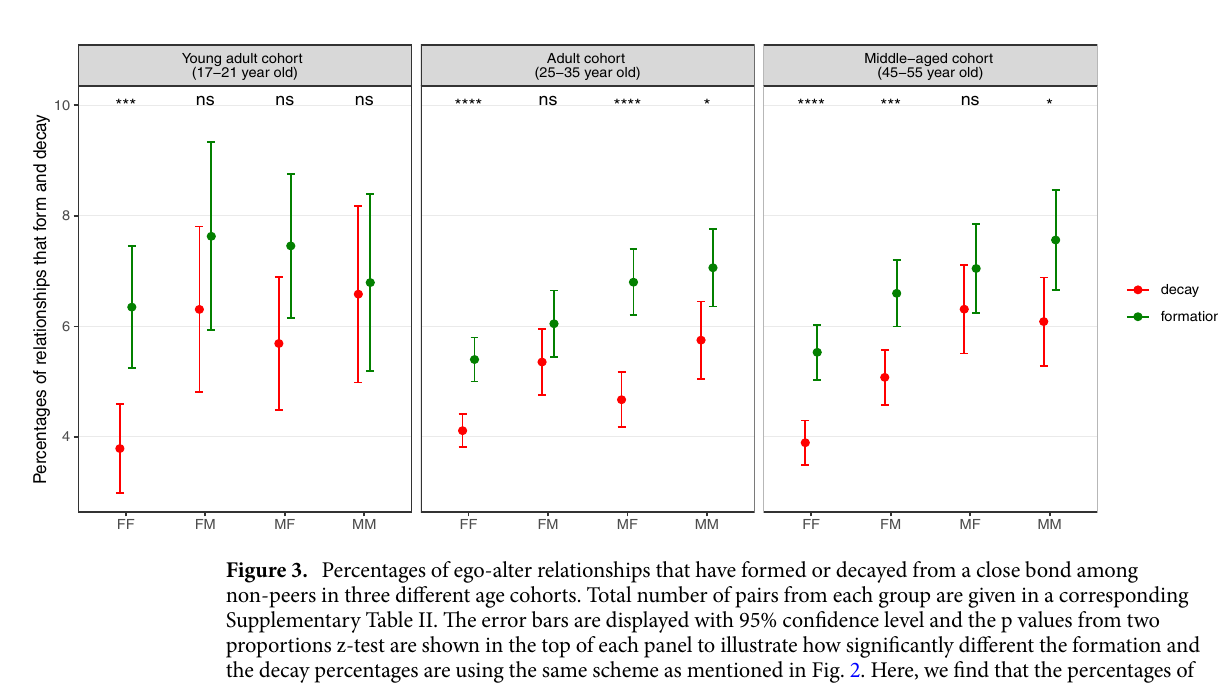
Figure 3. Percentages of ego-alter relationships that have formed or decayed from a close bond among non-peers in three different age cohorts. Total number of pairs from each group are given in a corresponding Supplementary Table II. The error bars are displayed with 95% confidence level and the p values from two proportions z-test are shown in the top of each panel to illustrate how significantly different the formation and the decay percentages are using the same scheme as mentioned in Fig. 2. Here, we find that the percentages of formation are comparatively higher than percentages of decay for adult and middle-aged cohorts. Particularly, the FF group has a higher percentage of formation than decay in all age groups. The corresponding percentage values for this graph is shown in Supplementary Table